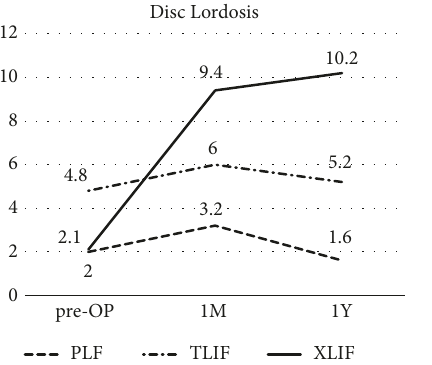
Figure 4: Disc lordosis before operation, 1 month after the surgery, and 1